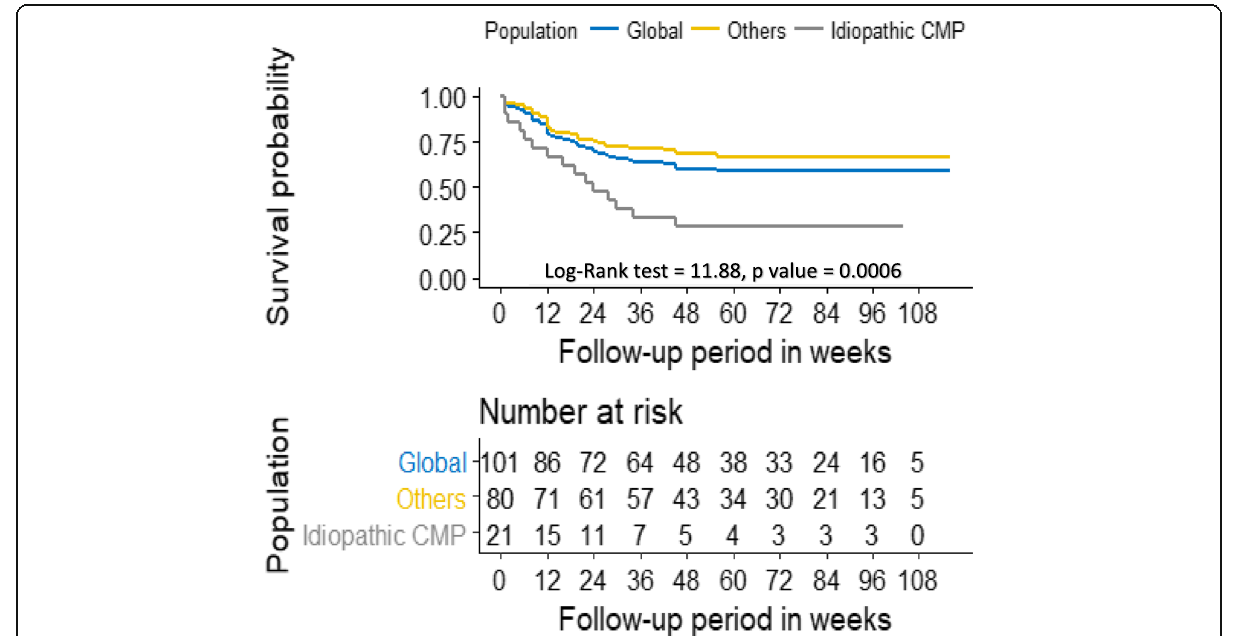
Fig. 2 Kaplan-Meier survival curves for all population and patients stratified by the presence and absence of idiopathic cardiomyopathy